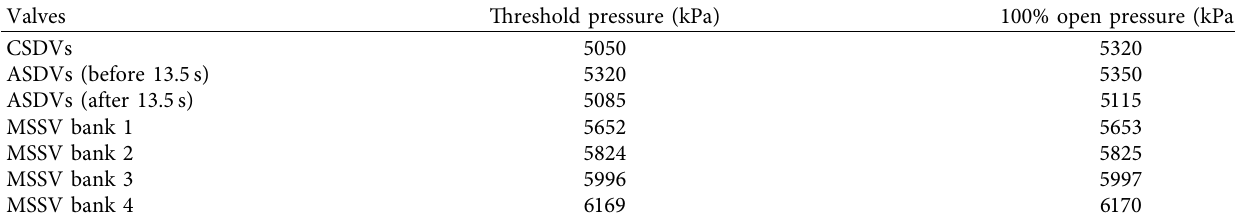
Table 1: Pressure setpoints for steam discharge